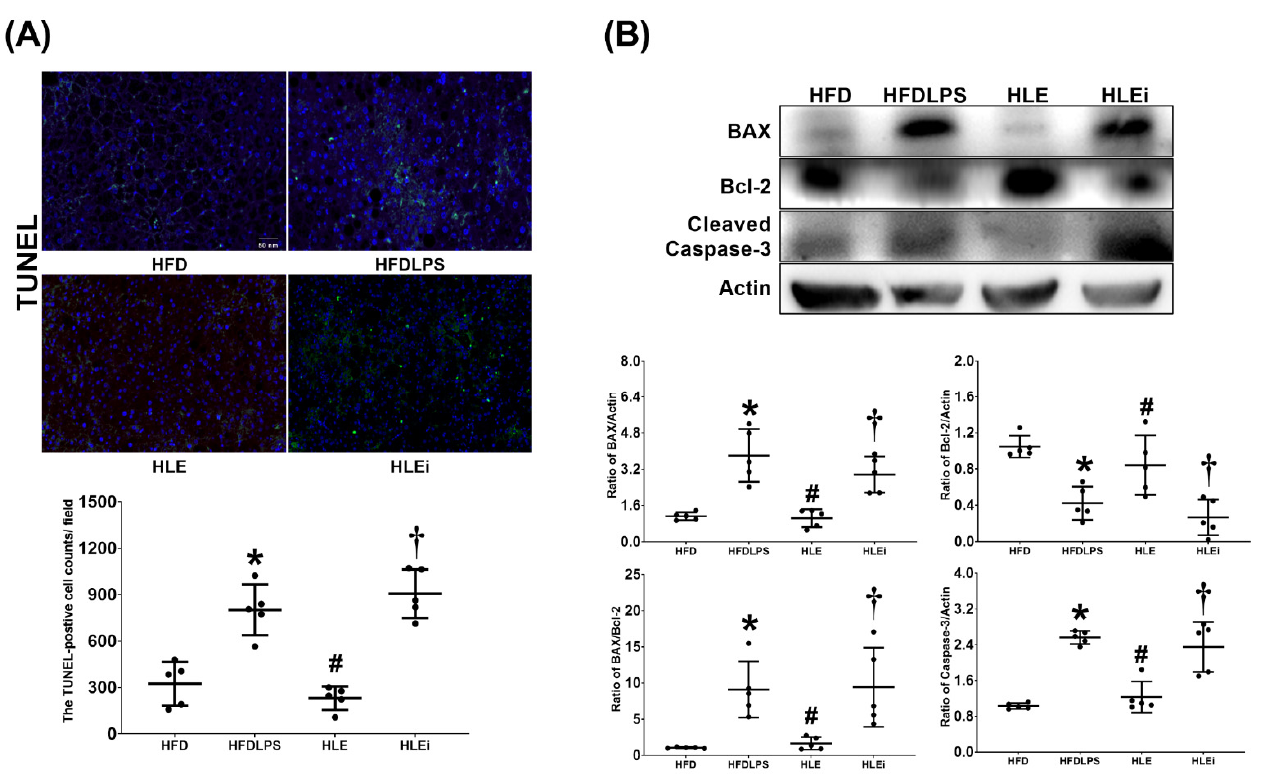
Figure 6. ( A ) Representative DNA fragmentation microscopic images (the indicator of apoptosis, marked by green fluorescence dots, 200 × ) in liver tissues assayed using the terminal deoxynu- cleotidyl transferase dUTP nick end labeling (TUNEL) method and the count of TUNEL-positive cells (0.25 mm 2 ). Data were obtained from 5 mice in each group ( B ) Representative gel images of the proapoptotic BAX, the antiapoptotic Bcl-2, proapoptotic cleaved caspase-3, and actin (the internal standard) in liver tissues assayed using an immunoblotting assay, and the relative band density of BAX/actin, Bcl-2/actin, cleaved caspase-3/actin, and BAX/Bcl-2 ratios in liver tissues. Data were obtained from 5 mice in each group. All assays were performed 48 h after endotoxin or nor- mal saline (NS) administration in the surviving mice. Data were presented as means ± standard deviations. HFD: the high-fat diet plus intraperitoneal (ip) administration of NS (0.5 mL) group. HFDLPS: the high-fat diet plus endotoxin (10 mg/kg, ip) group. HLE: the high-fat diet plus endo- toxin plus exosomes (from human placenta choriodecidual membrane-derived mesenchymal stem cells, pcMSCs, 1 × 10 8 particles per mouse, ip) group. HLEi: the high-fat diet plus endotoxin plus microRNA-inhibitor-pretreated exosomes (1 × 10 8 particles per mouse, ip) group. * p < 0.05, versus the HFD group; # p < 0.05, the HLE group versus the HFDLPS group. † p < 0.05, the HLEi group versus the HLE